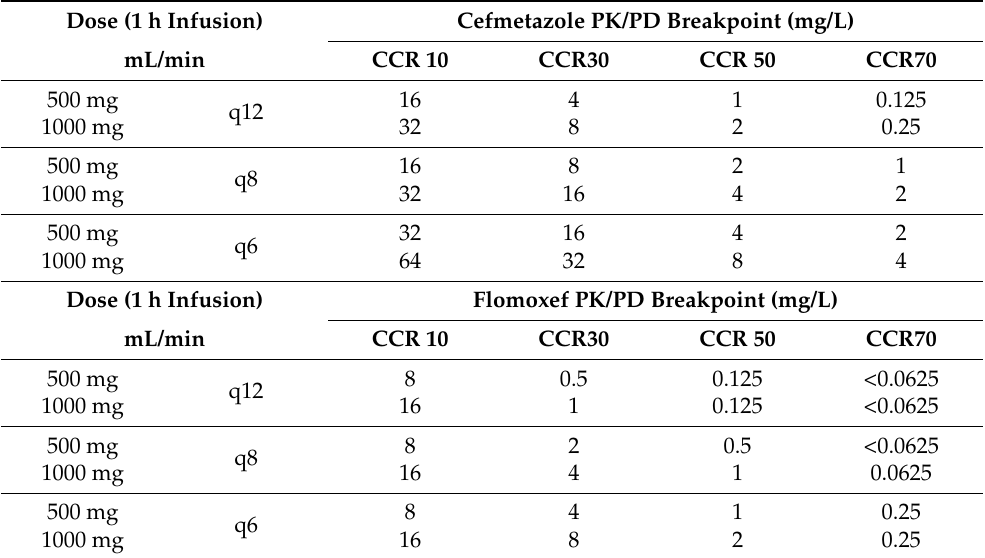
Table 2. Clinical pharmacokinetic/pharmacodynamic (PK/PD) breakpoints of UTIs caused by ESBLs for cefmetazole and flomoxef with PTA ≥ 90% for each renal